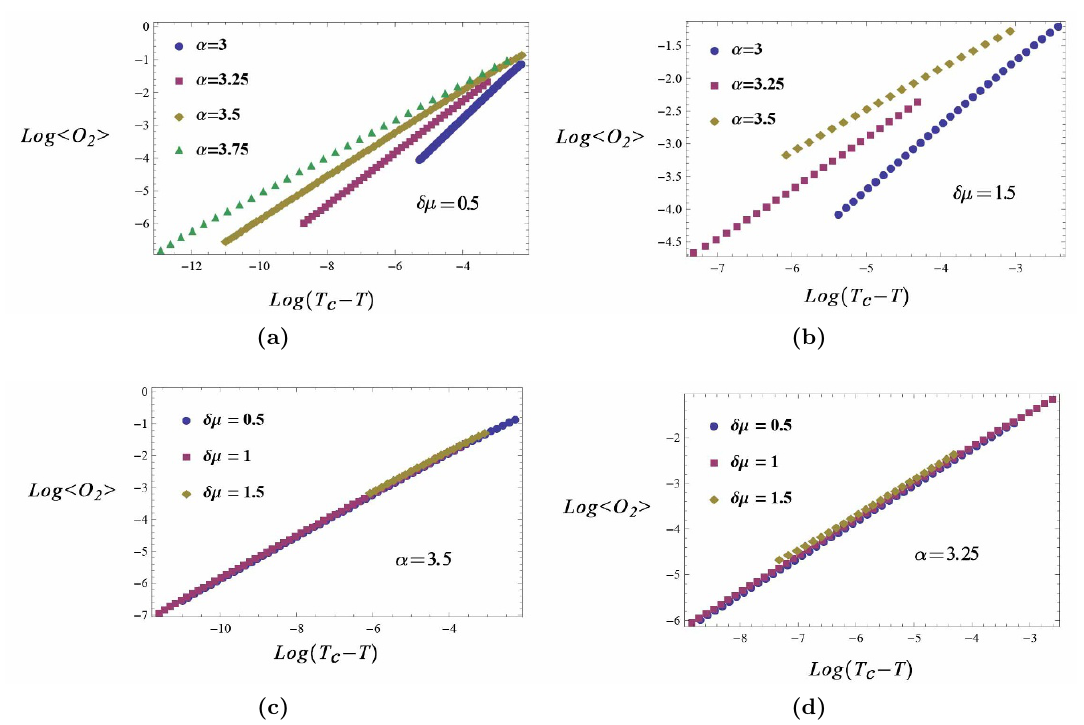
Figure 6. The value of the condensate near the critical temperature for function F ( ) = 2 (cid:0) (cid:11) + 4 . Each plot in the (cid:12)rst array indicates the condensation for (cid:12)xed (cid:14)(cid:22) = 0 : 5 ; 1 : 5 (left plot, right plot) and various values of (cid:11) . The plots in the second array indicate condensation for (cid:12)xed (cid:11) = 3 : 5 ; 3 : 25 (left plot, right plot) and di(cid:11)erent (cid:14)(cid:22) = 0 : 5 ; 1 ; 1 : 5. It shows that imbalance does not violate relation